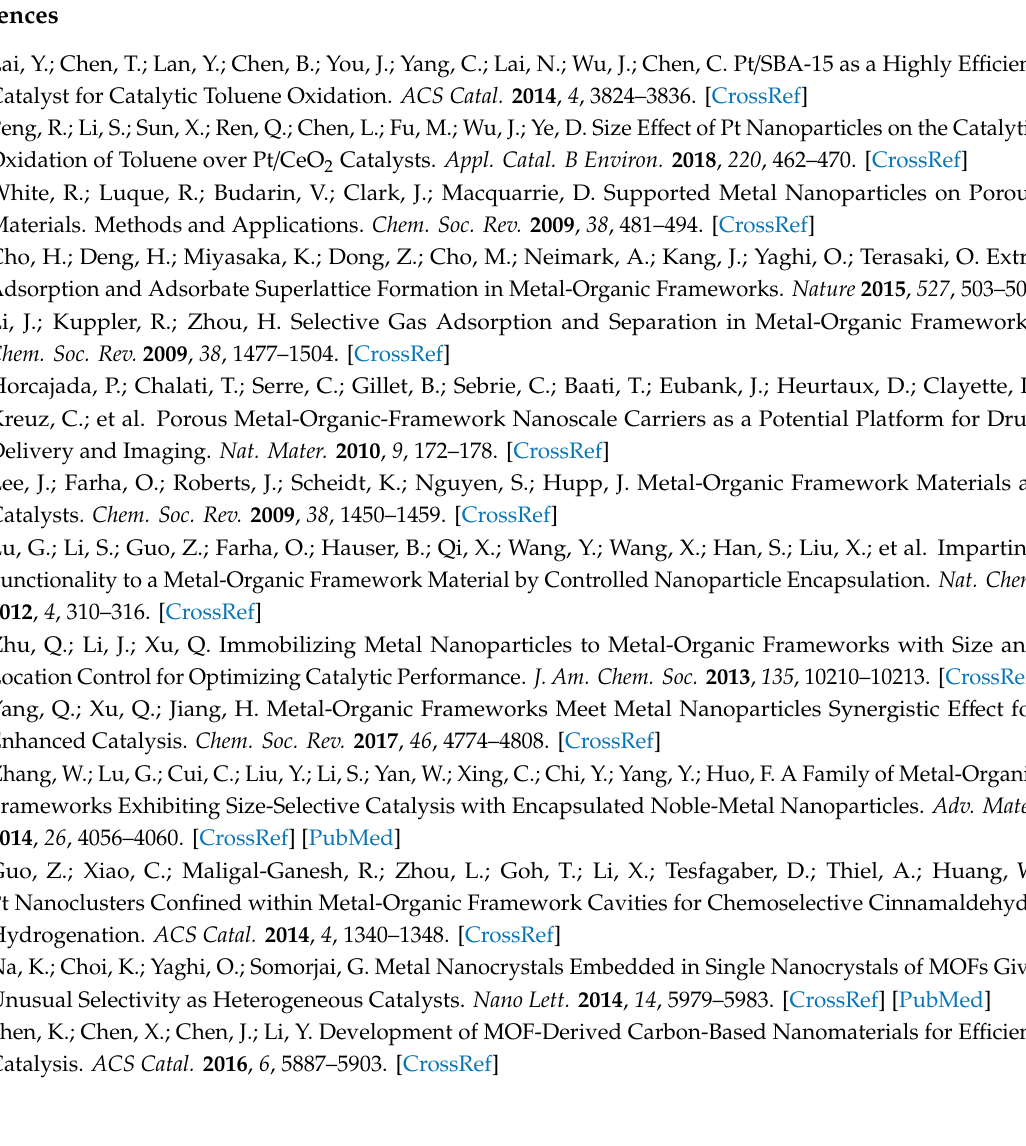
Figure S1: XRD patterns of Ce-BTC and Pt@Ce-BTC., Figure S2: Nitrogen adsorption-desorption isotherms and pore-size distributions of Ce-BTC and Pt@Ce-BTC, Figure S3:TGA curve of Ce-BTC, Figure S4: TEM images and Pt NPs size distribution histogram of Pt@Ce-BTC, Figure S5: Morphology and structure of Pt(Et)@CeO 2 (Air), Figure S6: Morphology and structure of Pt(Et)@CeO 2 (N 2 -Air), Figure S7: Nitrogen adsorption-desorption isotherms and pore-size distribution of the CeO 2 and Pt@CeO 2 , Figure S8: Conversion of toluene over Pt@CeO 2 with three consecutive cycles, Figure S9: In situ UV Raman spectra, Figure S10: The oxygen activation ability over Pt@CeO 2 , Figure S11: In situ UV Raman of Pt(EG)@CeO 2 (N 2 -Air), Table S1: Surface area and pore volume data for Ce-BTC and Pt@Ce-BTC, Table S2: Structural properties of various functional MOFs derivatives, Table S3: